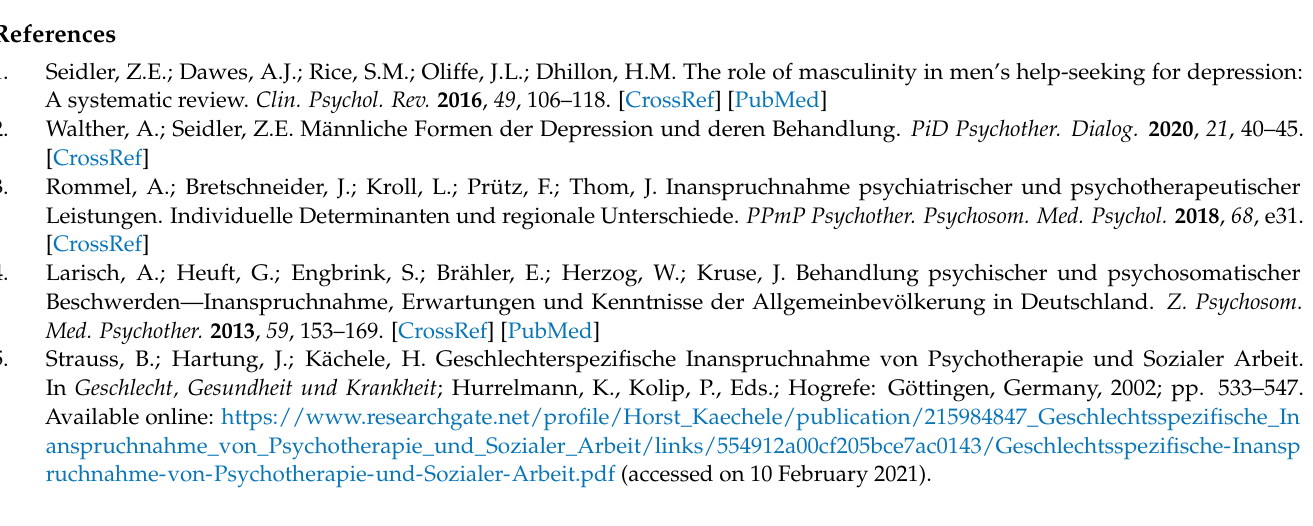
Interaction Effects in Female Participants, Table S1: Group Comparisons for Heterosexual Male and Female Participants, Table S2: Second-Order Partial Correlation Matrices for the applied Question- naires, Table S3: Summary of Binary Logistic Regression Models controlled for Covariates for Male Participants, Table S4: Summary of Binary Logistic Regression Models controlled for Covariates for Female